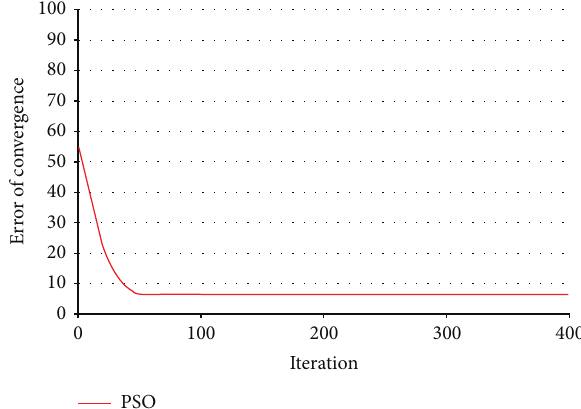
Figure 8: Converge of PSO during 400